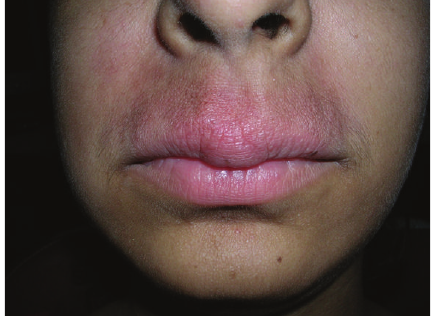
Figure 1: Pretreatment view of the swelling in the first patient showing diffuse, erythematous swelling of upper lip.